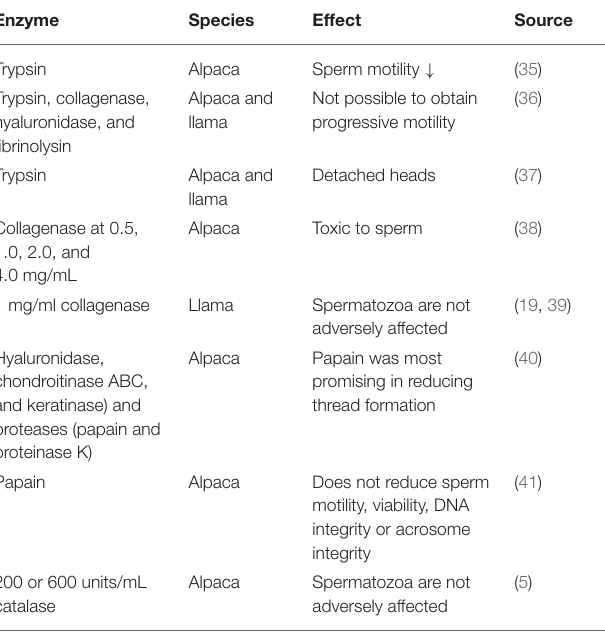
TABLE 2 | Summary of various studies on enzyme treatment of semen from South American